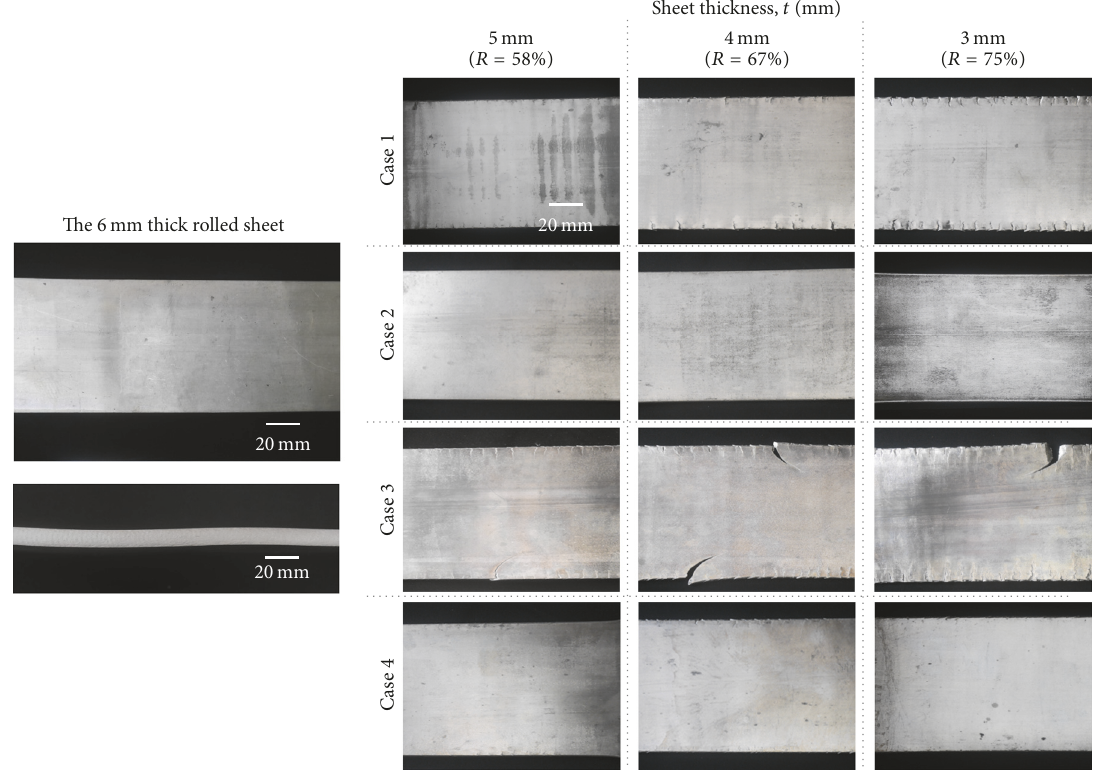
Figure 8: The appearance of the AZX811 rolled sheet at each rolling temperature, sample temperature, and sheet thickness.